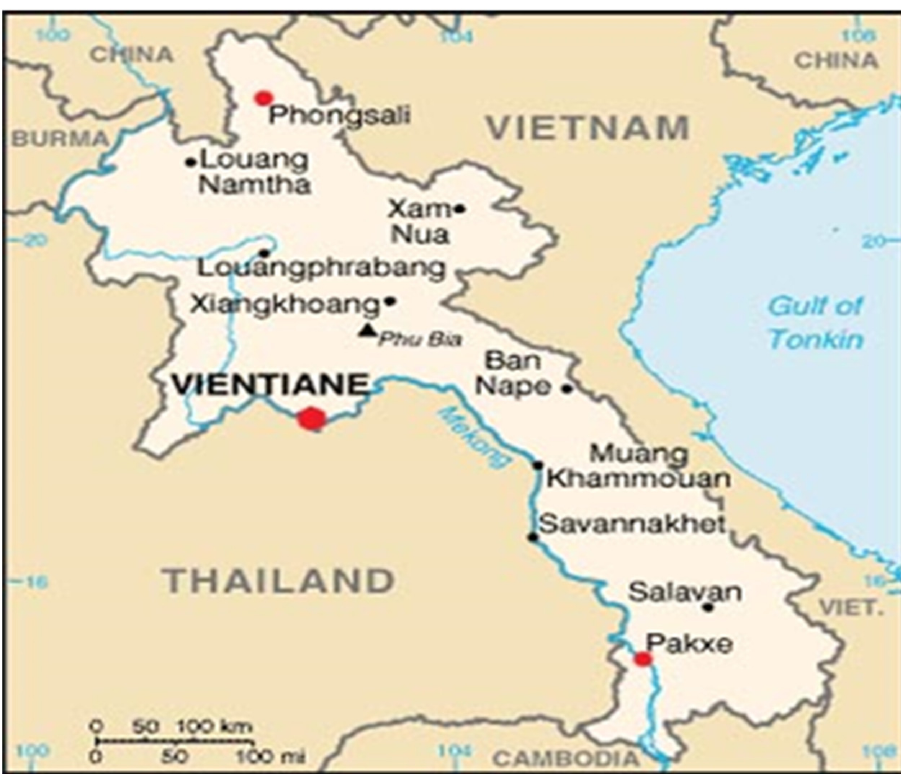
Figure 1. Map of Laos and location of the study area, Pakxe (red rectangle). Source: http://www.worldatlas.com/webimage/countrys/asia/laos/lalatlog.htm, accessed on 4 July 2022.